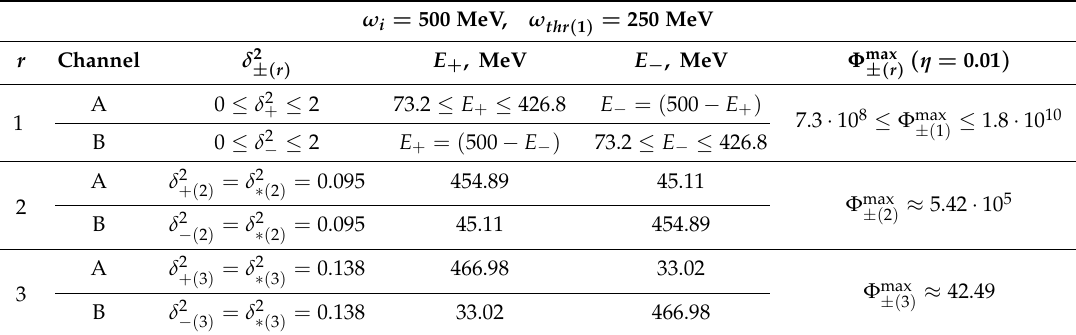
Table 1. The most probable values of the electron-positron pair energies and the corresponding resonant differential cross sections for the case ε r ∼